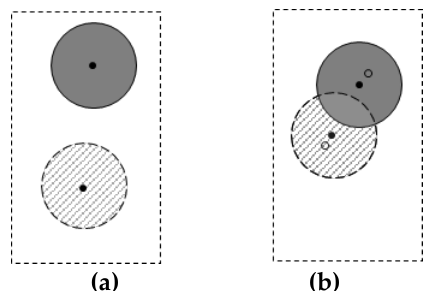
Figure 3. Sketch of moving particles in two successive frames with ( a ) low frequency, and ( b ) high frequency. The dashed and solid circles represent particles in the first and second frames, respectively. The solid round represents a real particle center, and the circle is the particle centroid based on the subtraction procedure.